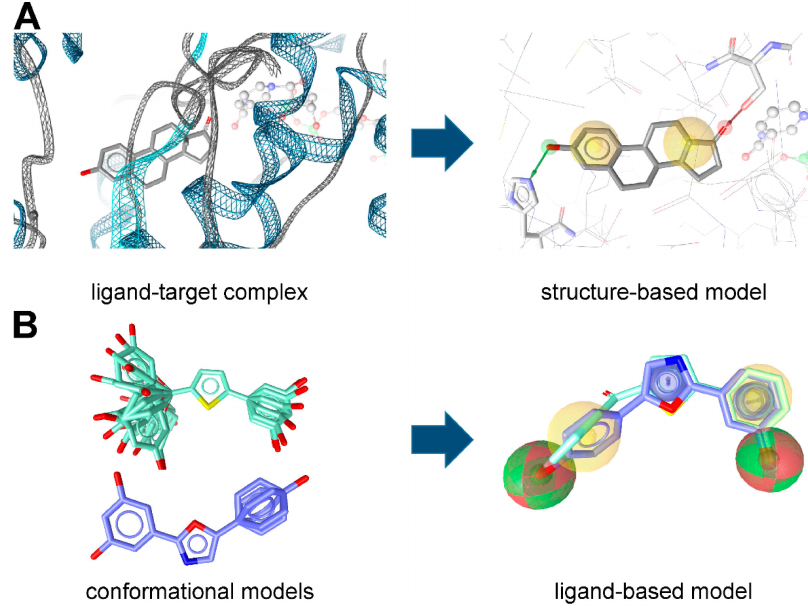
Figure 2. ( A ) Structure- and ( B ) ligand-based pharmacophore model generation with LigandScout. ( A ) Based on the complex of equilin bound to 17 β -HSD1 (PDB entry 1EQU [5]), an initial pharmacophore model is created automatically; ( B ) Conformational models of known 17 β -HSD1 ligands [13,14] are used to align the compounds and extract pharmacophore features they